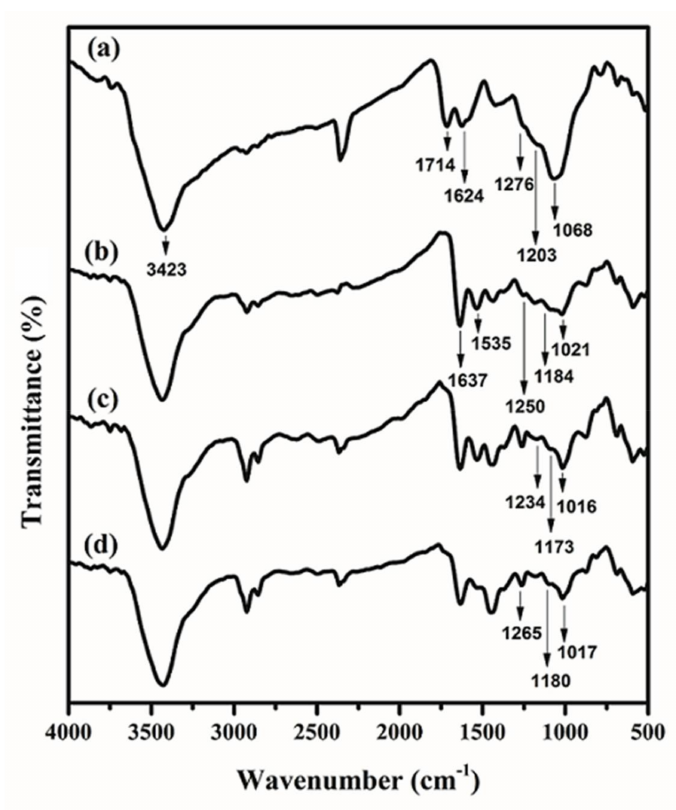
Figure 2. FTIR spectra of (a) GO; (b) GO/PAMAM; (c) congo red (CR)-adsorbed GO/PAMAM; and, (d) GO/PAMAM at pH =